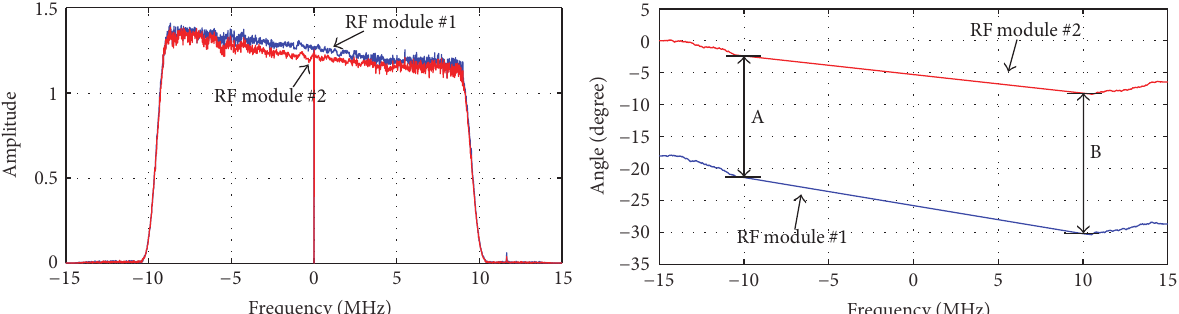
Figure 3: Amplitude/phase of the 2 RF modules measured in the implemented test-bed.